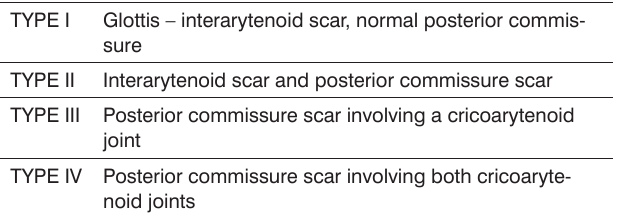
Table 1. Classification of Posterior Glottic Stenosis (Bogdasa- rian & Olson 8